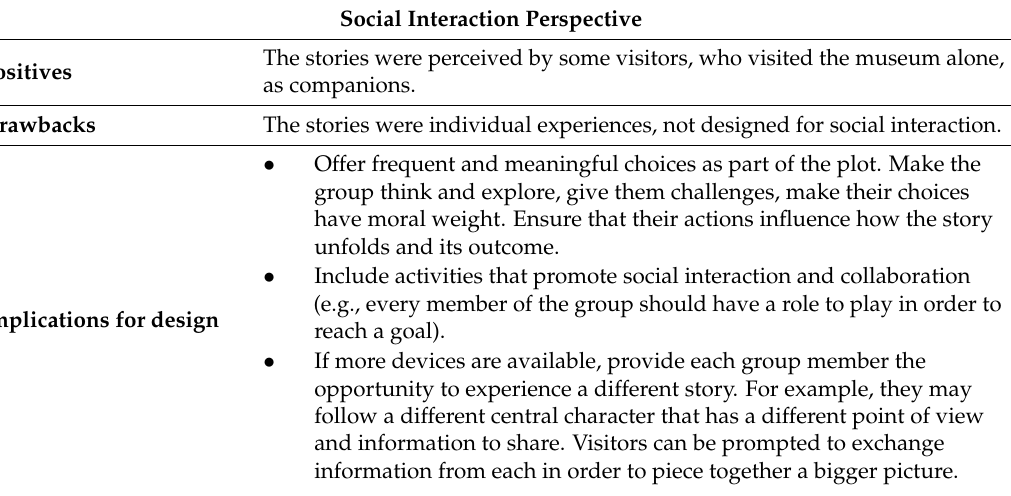
Table 8. Insights from findings on the social perspective, and implications for